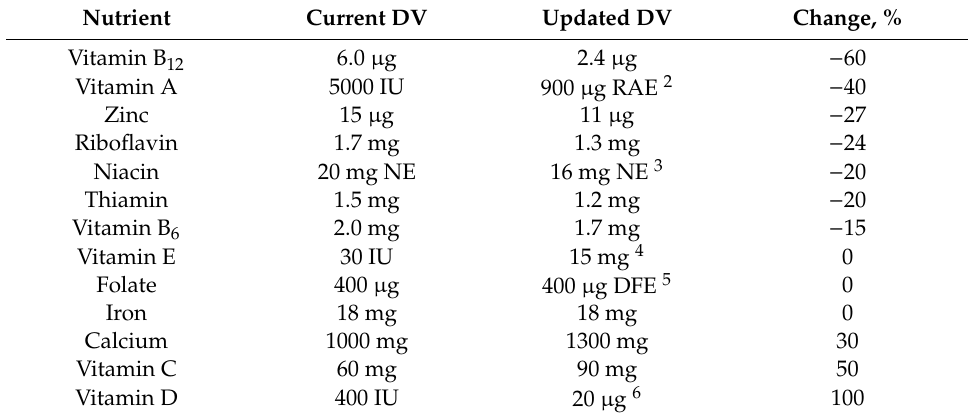
Table 1. Current and updated Daily Values (DVs) for food labels for adults aged ≥ 19 years 1 in the US